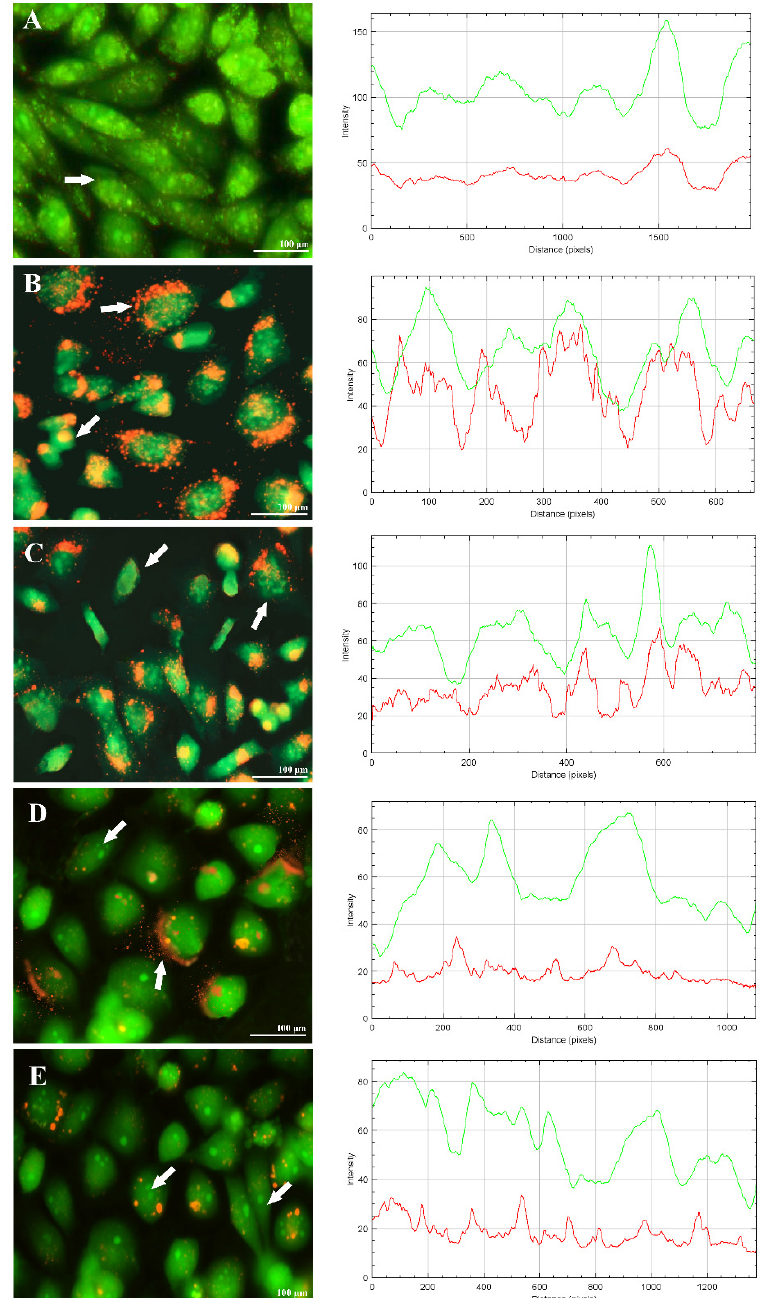
Figure 6. Fluorescence viewing (40X) of the PC12 cell line, after treating them with H 2 O 2 along with various test samples for 12 h. Image Description: ( A ) Control ( B ) H 2 O 2 ( C ) H 2 O 2 with NPs ( D ), H 2 O 2 with APO ( E ) H 2 O 2 with APO-NPs.